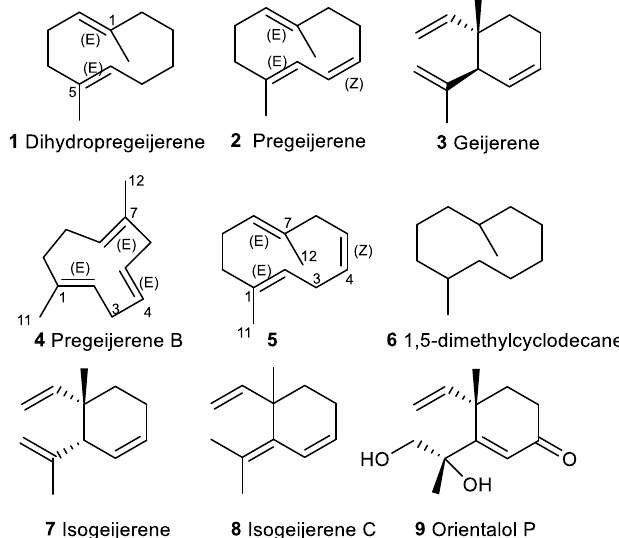
Figure 2. Molecular structure of 11,12,13-tri- nor -germacranes and -elemanes. Pregeijerene ( 2 ) has been isolated from the EO of different species of the Rutaceae Compound 1, called dihydropregeijerene, is one of the tri -nor -germacranes that is a family, in which Ruta graveolens is the most common plant and the one from which this compound has been studied